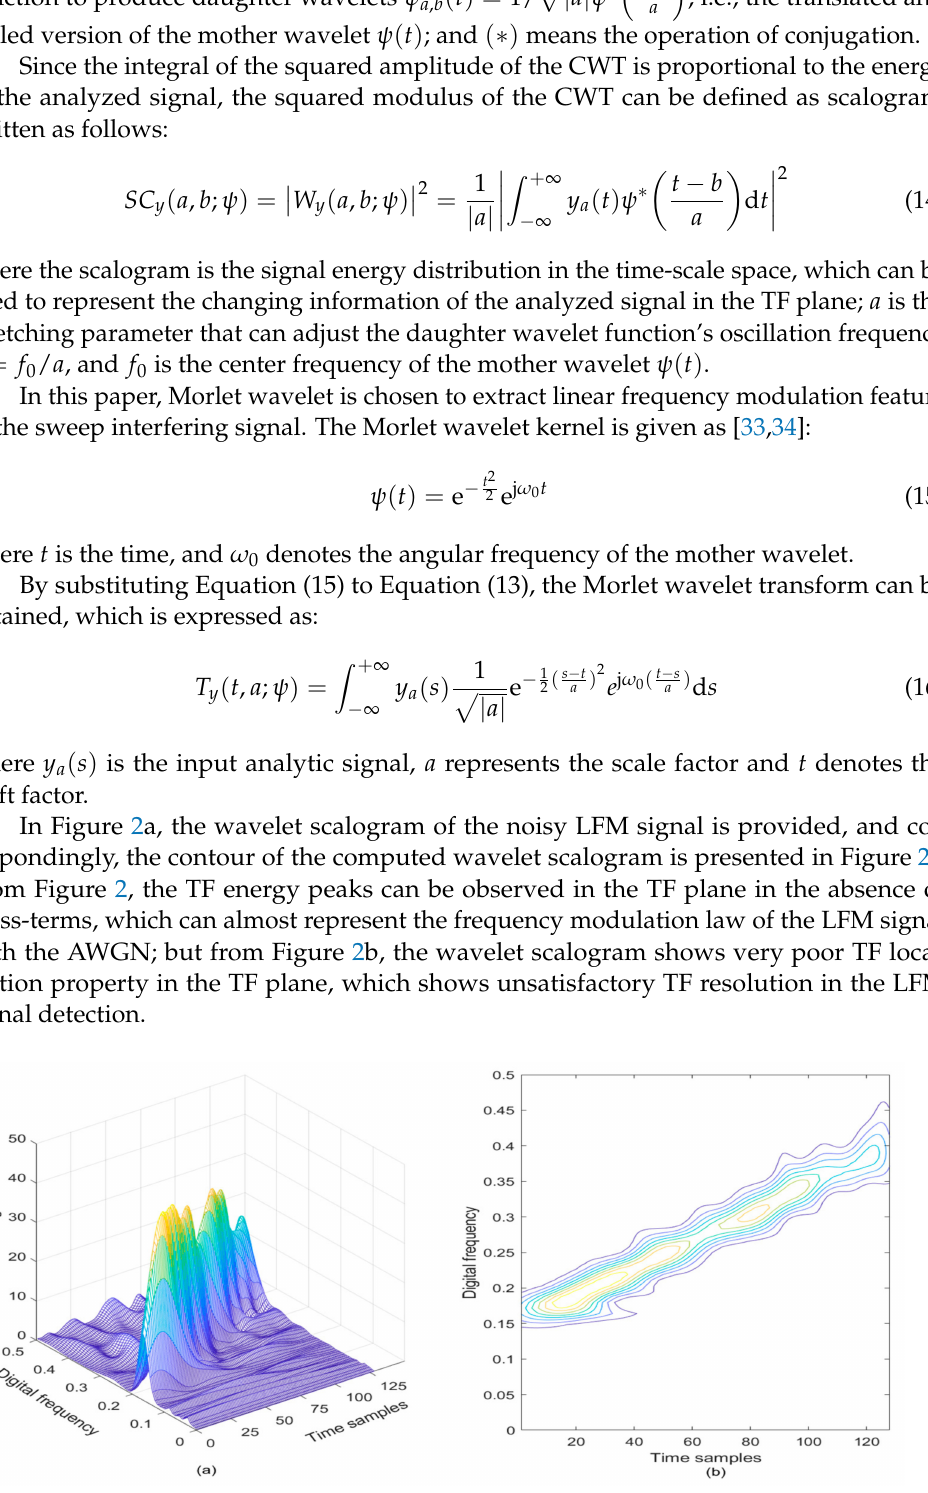
Figure 2. The wavelet scalogram of the LFM signal in the presence of AWGN, where the SNR is set to be 3 dB. ( a ) Wavelet scalogram; ( b ) Contour of wavelet